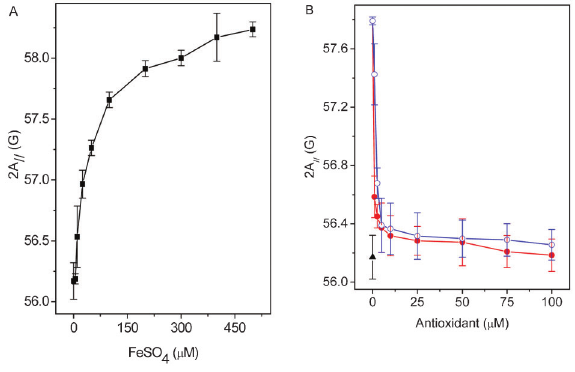
Figure 7. A , FeSO 4 concentration dependence of the EPR parameter 2A // of the spin label 5-DSA in erythrocyte ghost membranes. The erythrocyte ghost membranes were incubated with 2 mM H 2 O 2 and different concentrations of FeSO 4 for 3 h at 37 6 C. B , Antioxidant activity of 4-NC (filled circles) and a -tocopherol (open circles) as evaluated by the spectral parameter 2A // . Non-oxidized membranes were used as the control (filled triangle). The erythrocyte membranes were previously incubated with antioxidants for 1.5 h at 37 6 C and then incubated with 0.2/2 mM FeSO 4 /H 2 O 2 for 3 h at 37 6 C. EPR: electron paramagnetic resonance; 5-DSA: 5-doxyl stearic acid; 4-NC: